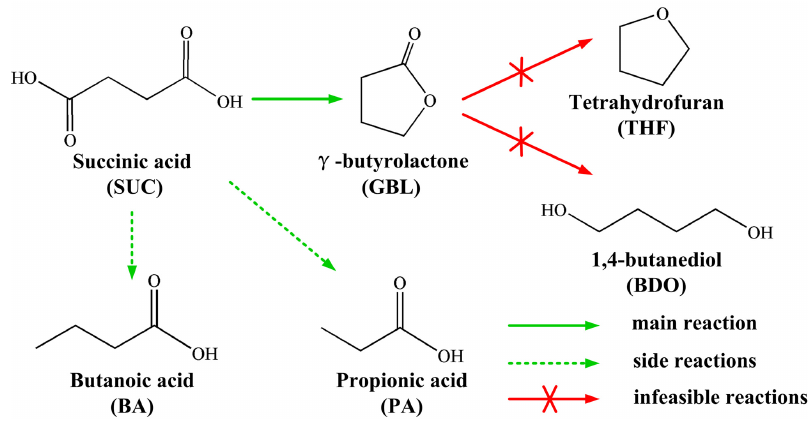
Scheme 1. Reaction routes of succinic acid catalytic hydrogenation over subnanometer Pd